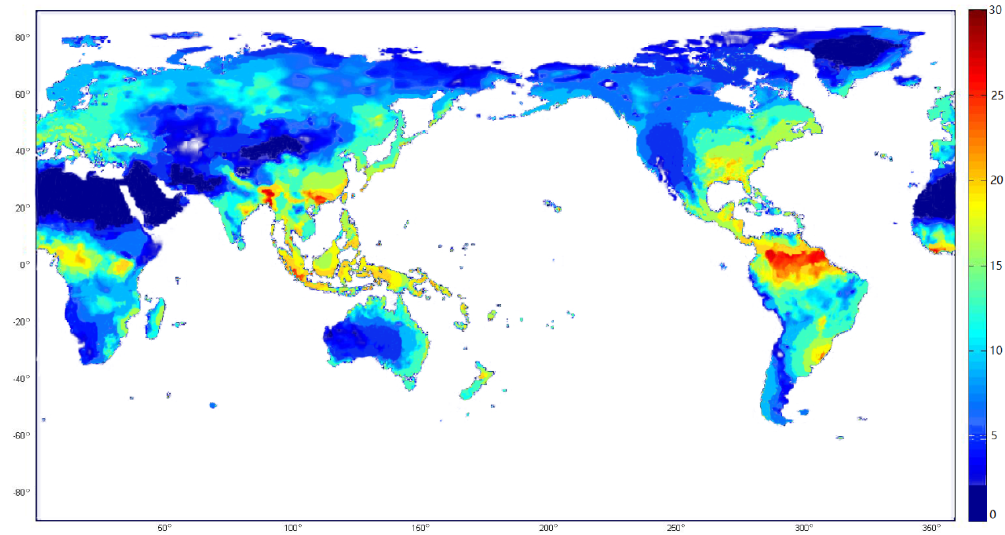
Figure 3. Simulated spatial distribution of BNF rates (kg N 2 ha − 1 yr − 1 ) in natural terrestrial ecosystems from 1990 to 2000 by considering the BNF